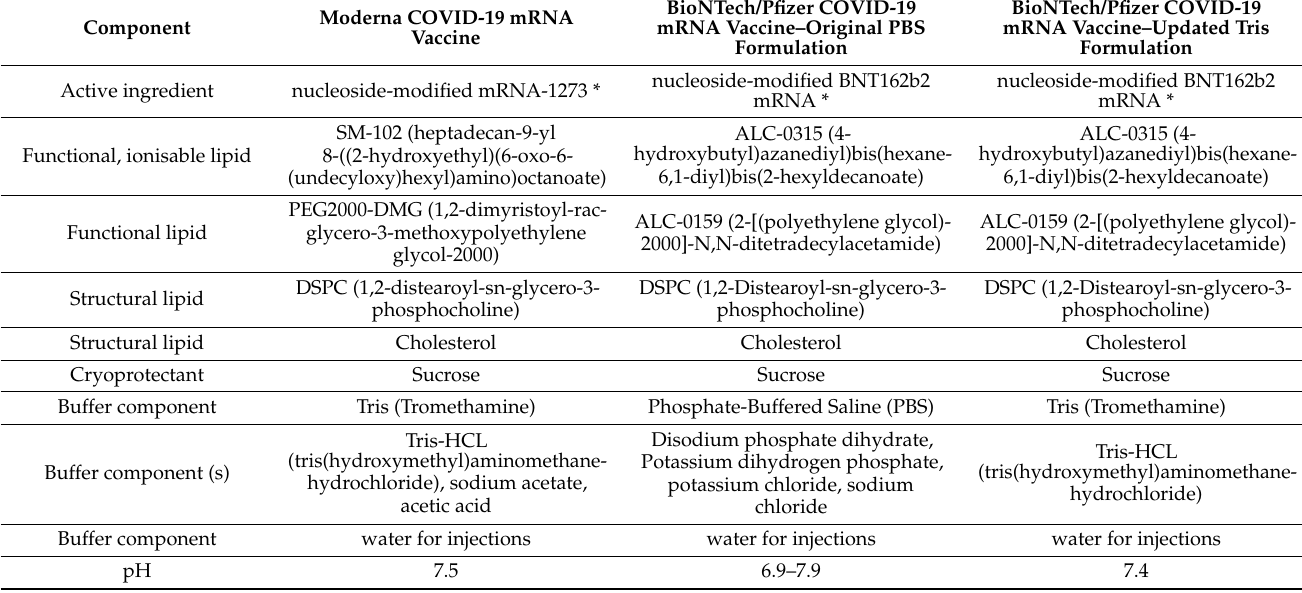
Composition of the Moderna and BioNTech/Pfizer COVID-19